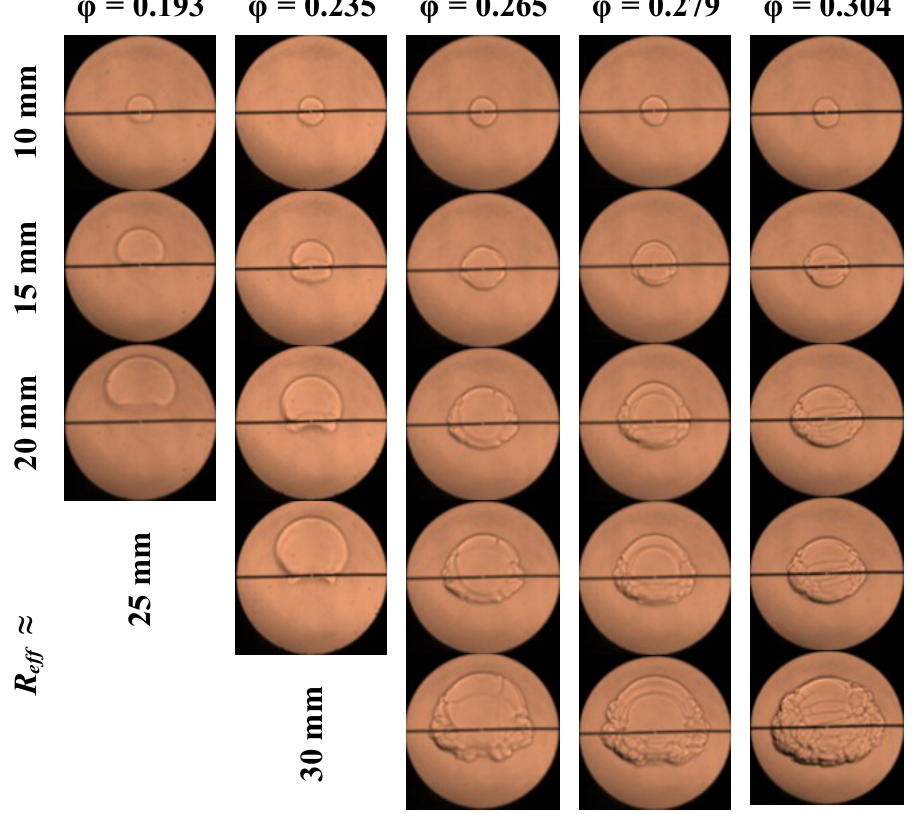
Figure 4. Schlieren images of hydrogen-air premixed flames with different equivalent ratios at atmospheric pressure and room